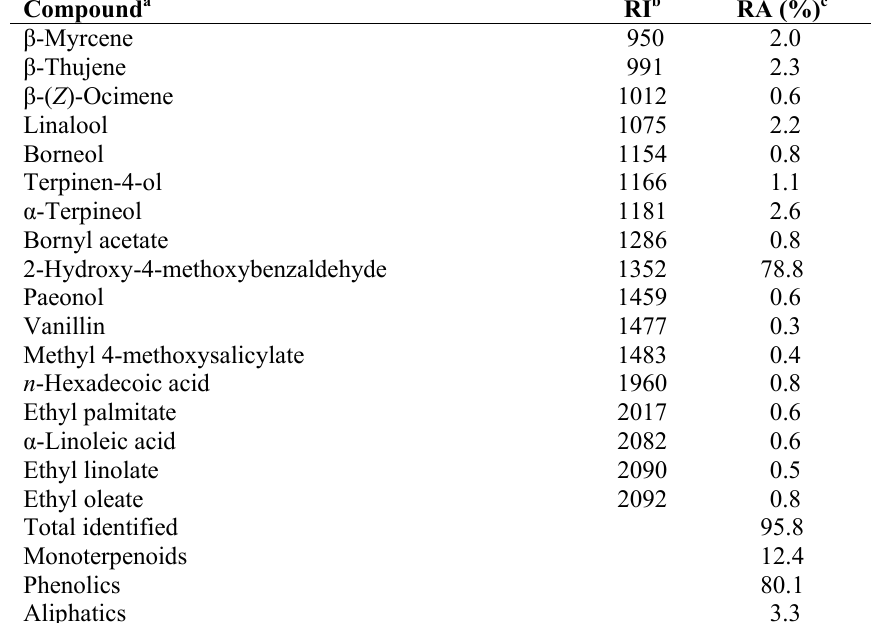
Table 1. Chemical composition of the essential oil from the root bark of P. sepium . Compound